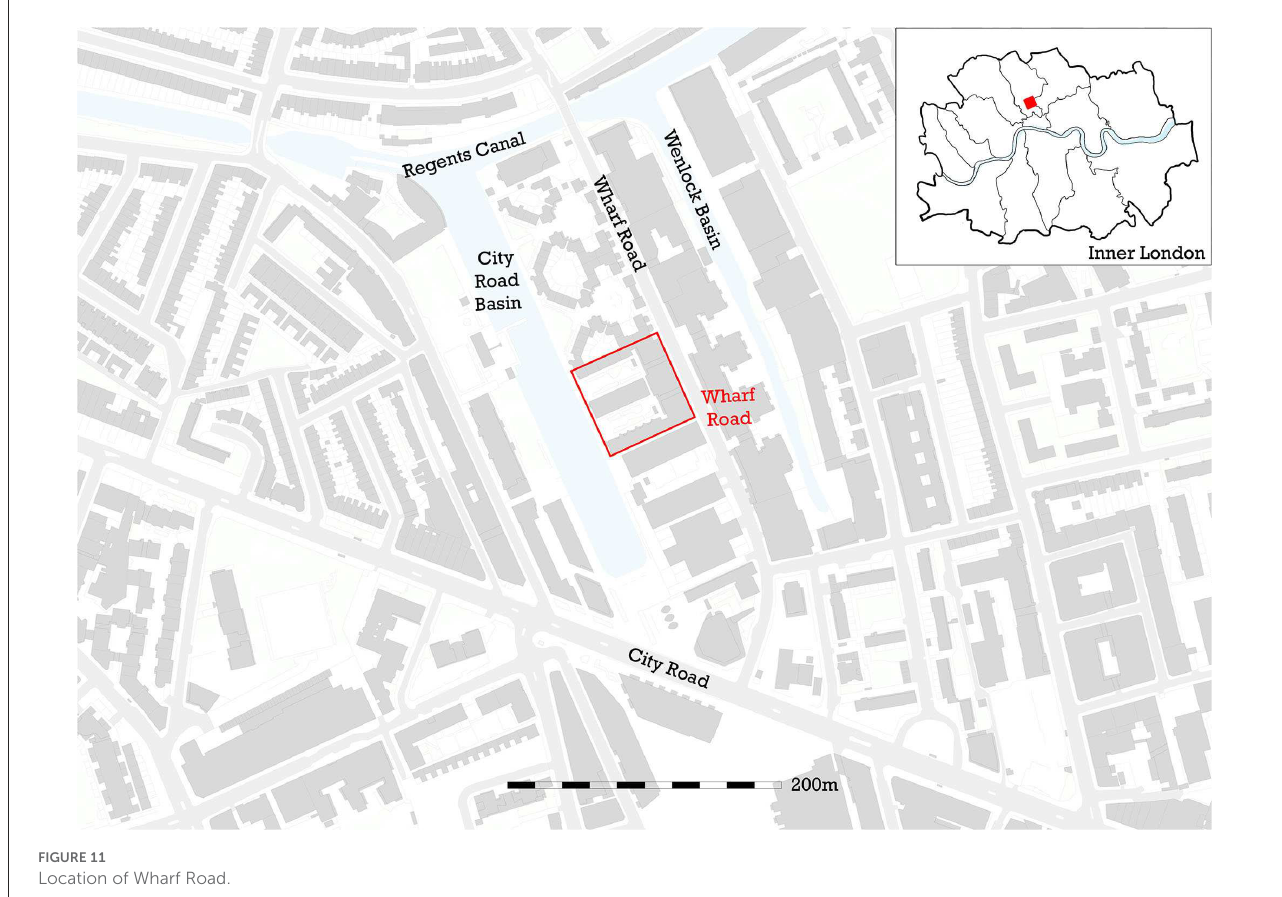
FIGURE11 Location of Wharf